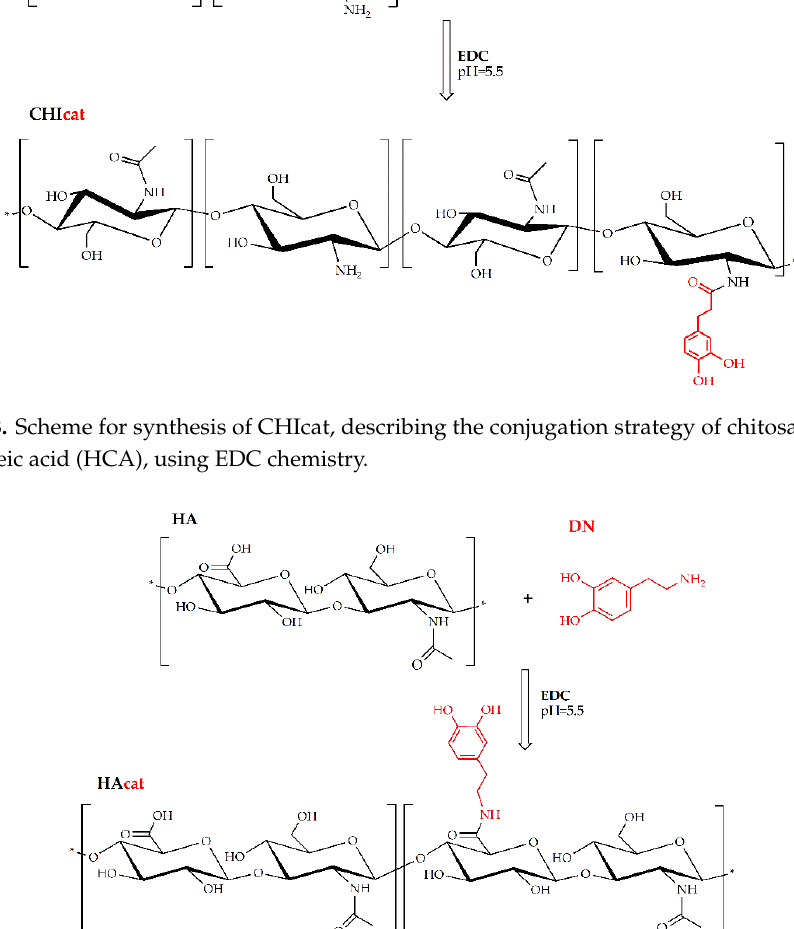
Figure A9. Scheme for synthesis of HAcat, describing the conjugation strategy of hyaluronic acid (HA) to dopamine (DN), using EDC chemistry.